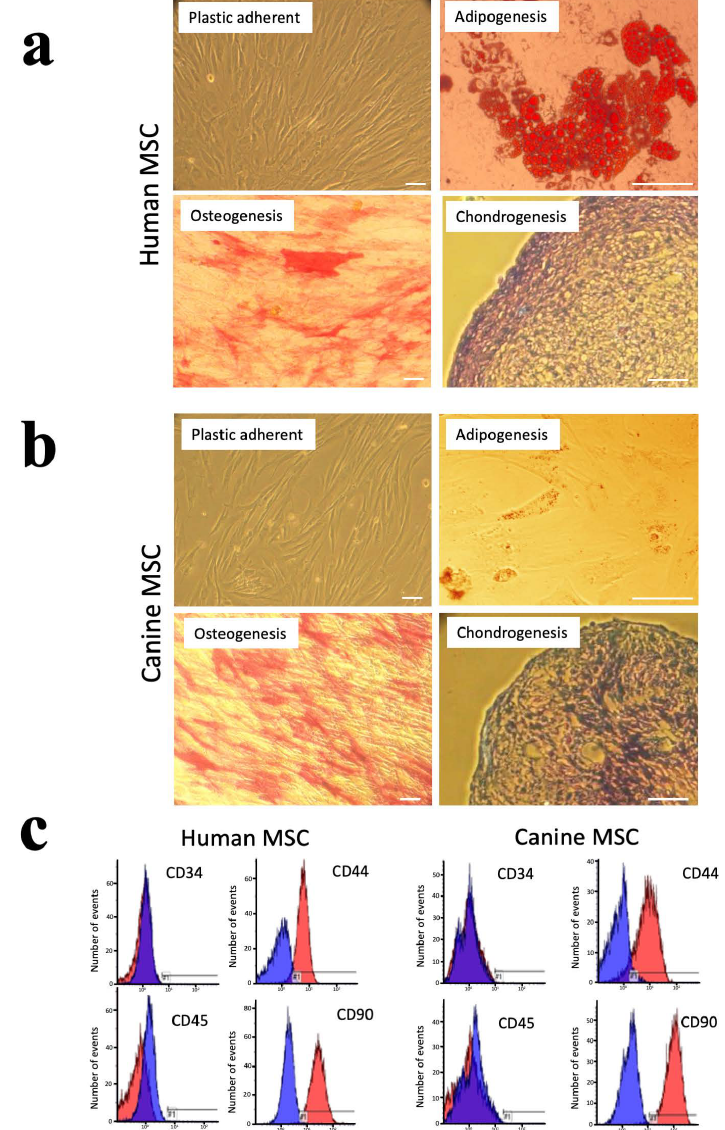
Figure 1. Phenotypic characterization of human and canine mesenchymal stem cells (MSCs). ( a ) Human MSCs were plastic adherent with a fibroblastic morphology under phase-contrast microscopy (top left panel). Following induction, human MSCs showed Oil Red O positivity, alkaline phosphatase positivity and secreted a toluidine blue-stained cartilaginous extracellular matrix, indicating their di ff erentiation potential to form adipocytes, osteoblasts and chondrocytes, respectively (as indicated). ( b ) Canine MSCs exhibited a similar phenotype, although their propensity to di ff erentiate to form Oil Red O positive adipocytes was less marked. Scale bars = 50 µ m. ( c ) Representative histograms of flow cytometric analysis of human (top panels) and canine (bottom panels) MSCs following immunocytochemical staining for CD34, CD44, CD45 and CD90. Immunoreactivity with irrelevant isotype-matched control antibodies is shown in blue, while immunoreactivity for each of the CD markers is shown in